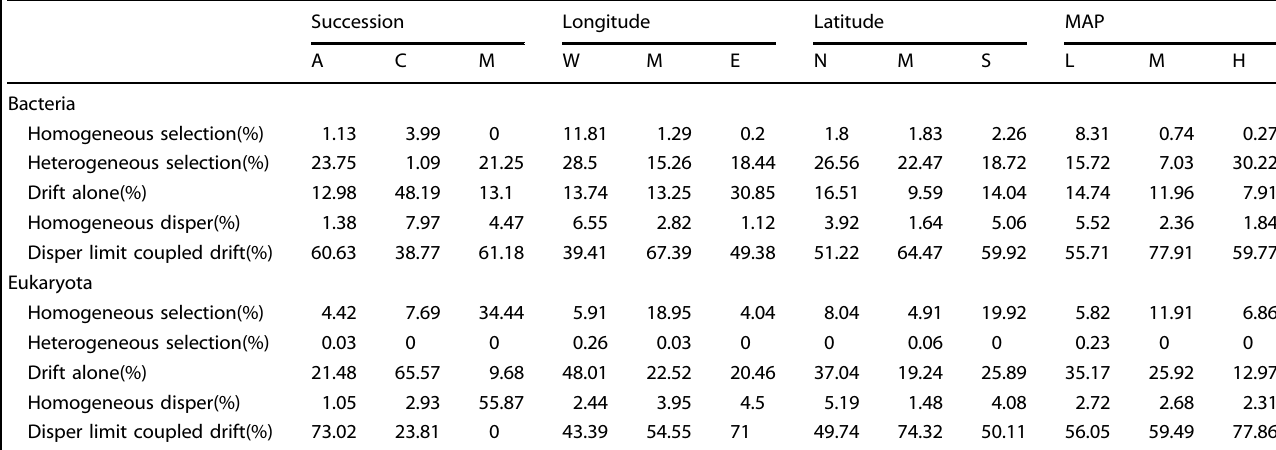
Table 1. Quanti fi cation of the relative roles of ecological processes in bacterial and eukaryotic community assembly. Values indicate the percentage of community turnover associated with each process.